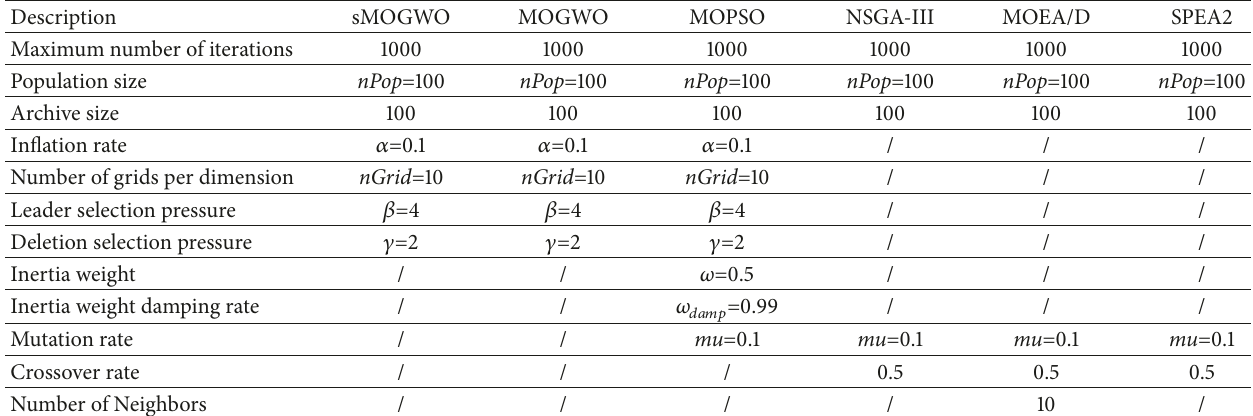
Table 1: The parameters of different multiobjective optimization algorithms.